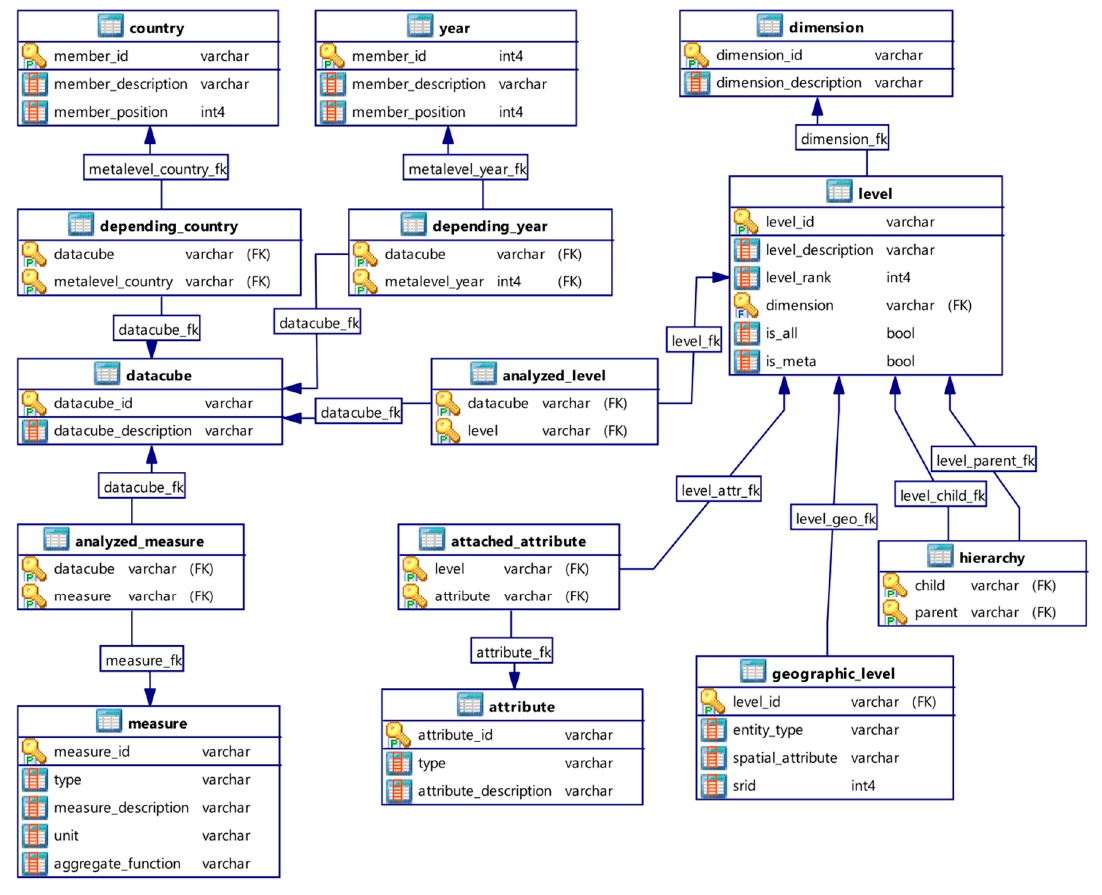
Figure 14. Logical data cube metamodel for a relational data warehouse.